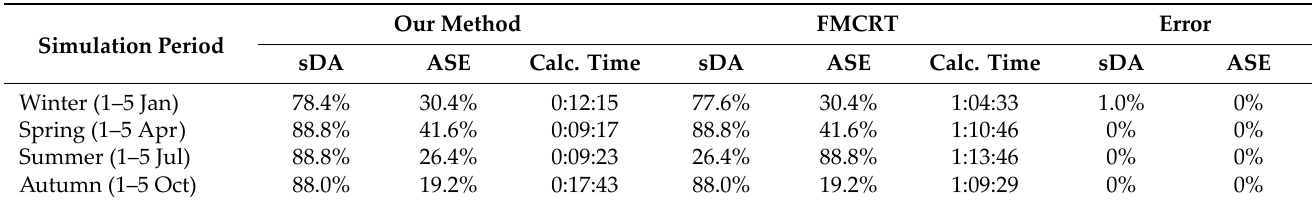
Table 4. Comparison of our method with FMCRT. The second verification scene (Figure 4).